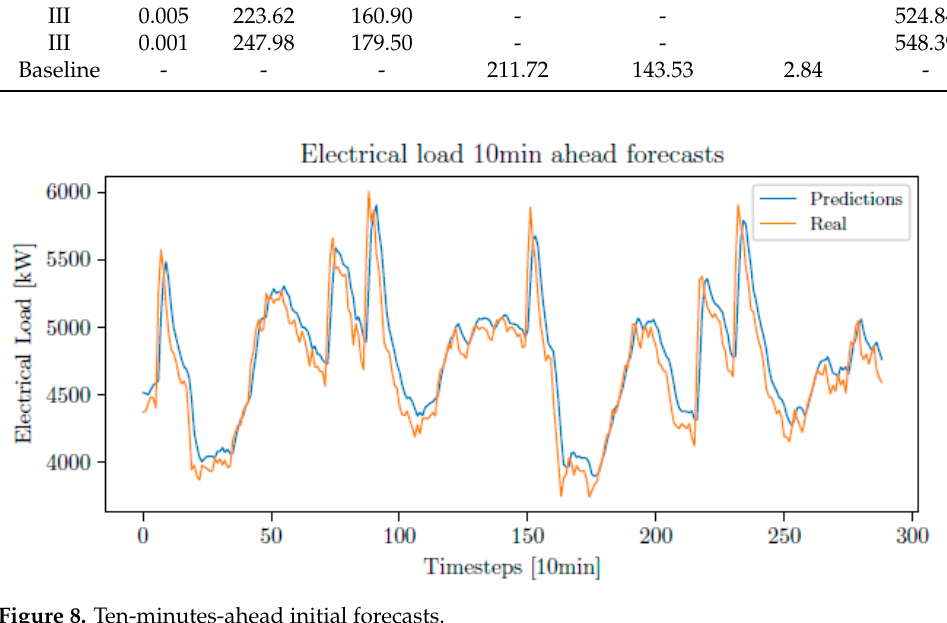
Table 4. Results of the 1-h-ahead initial and baseline models.